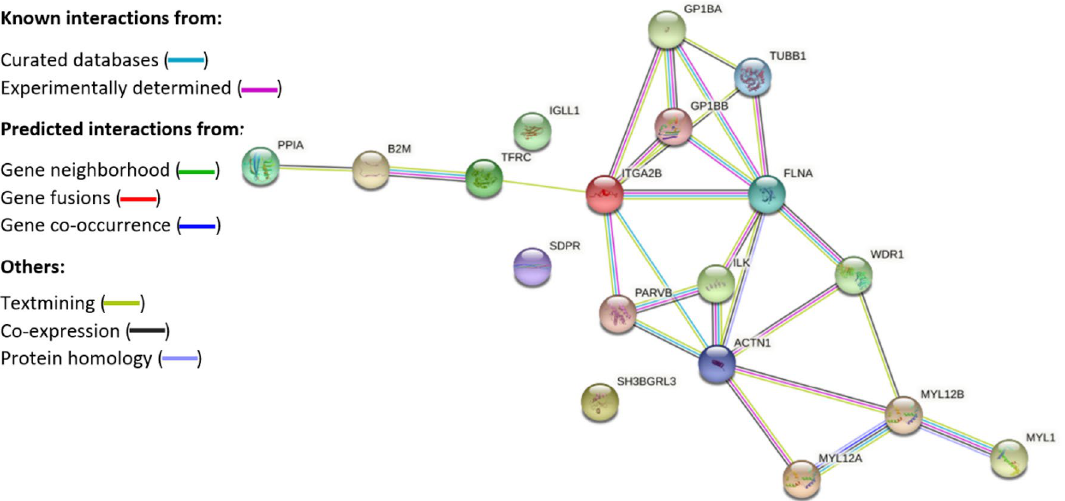
Figure 2. Protein–protein pathway analysis illustrating significantly upregulated proteins in POTS. Protein– protein interaction analysis of 18 out of 19 upregulated proteins with association networks detected by STRING in POTS. In the network figures, each protein is represented by a colored node while protein–protein interaction and association are represented by a line. The strongest network interactions in POTS were particularly associated with a hypercoagulable state and upregulated expression of proteins related to platelet activity, but also enhanced inflammation, cardiac contractility and hypertrophy, skeletal muscle expression, and adrenergic activity. Complete names of proteins are found in Table 2.